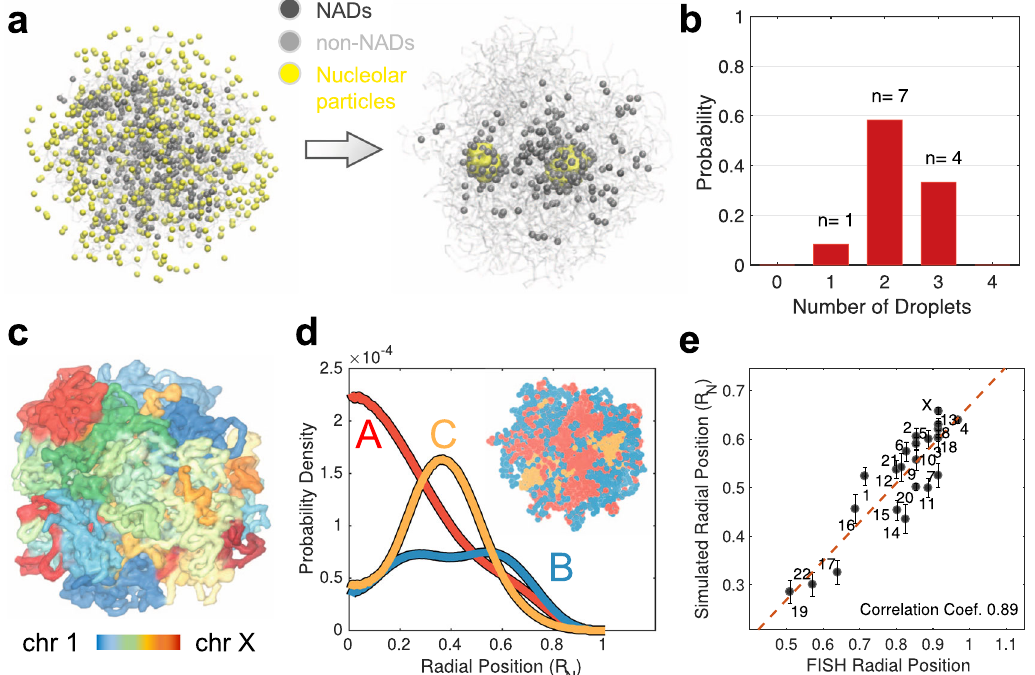
Fig. 2 Multiple droplets form in dynamical simulations of the nucleus model. a Representative initial (left) and fi nal (right) con fi gurations obtained from simulations, with nucleolar particles in yellow, NADs in black, and the rest of the genome in gray. b Probability distribution of the number of droplets observed at the end of simulation trajectories. c Representative con fi guration of the genome that illustrates the formation of chromosome territories. d Radial distributions of the different chromatin types that support their phase separation and preferential nuclear localization. An example genome con fi guration is shown as the inset, with the three types colored in red ( A ), blue ( B ), and orange ( C ), respectively. e Simulated radial chromosome positions correlate strongly with experimental values 63 . Error bars correspond to the standard deviation of the 12 mean values estimated using individual simulation trajectories. Homologous chromosomes were averaged together. R N is the radius of the nucleus used in polymer